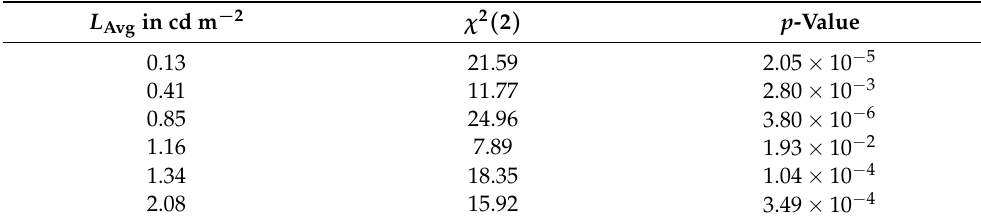
Table 2. Results of Friedman’s test for each of the six different average luminance levels of the combined near- and mid-field evaluation area. The results reveal a significant effect of driving speed for all luminance levels.